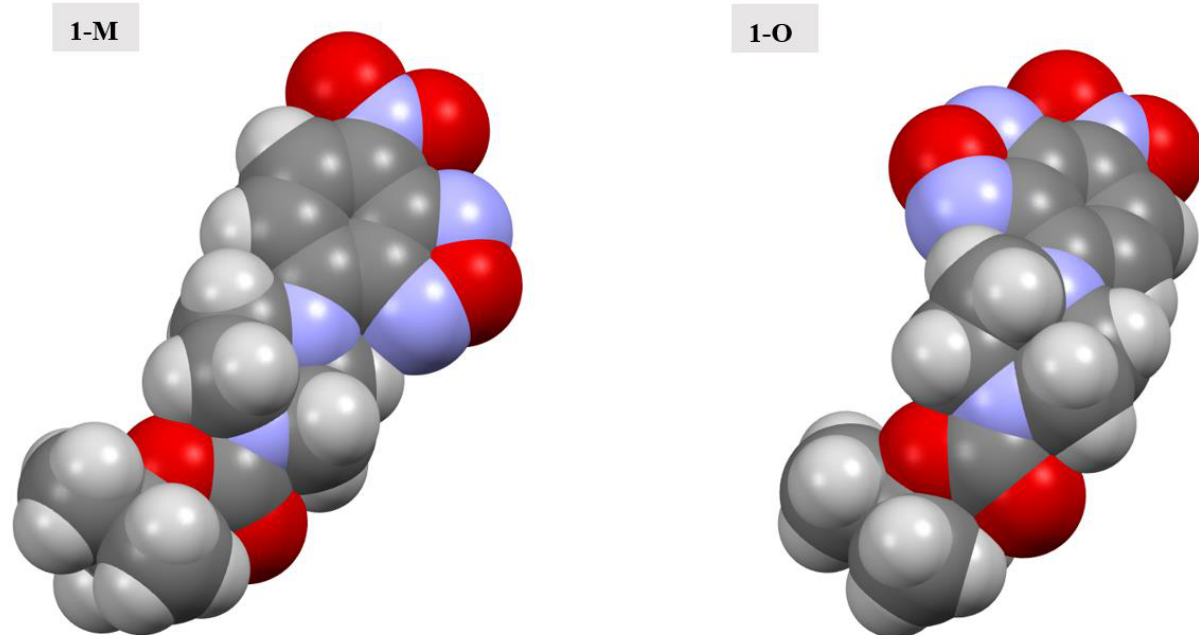
Figure 12. Spacefilling models of the molecular structures of 1-M and 1-O .